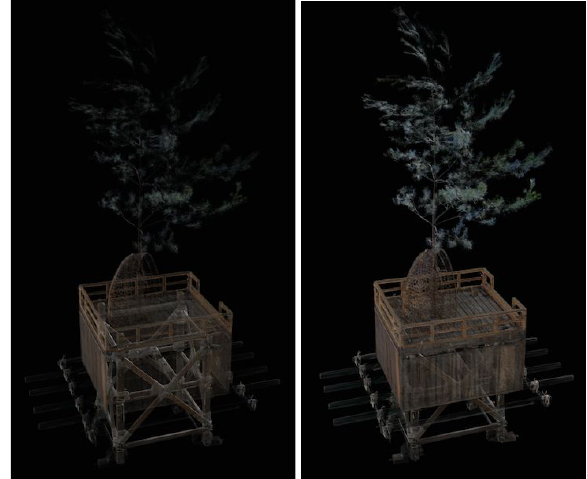
Figure 7. Assignment of different opacities to constituent point clouds in the transparent fused visualization. For the outer box- shaped portion, (cid:11) is 0 : 05 (small) in the left image, and (cid:11) is 0 : 2 (larger) in the right image. For the inner portion, (cid:11) is 0 : 8 in both images. The left image is suitable for observing the inner structure, whereas the right image is suitable for visualizing the outer